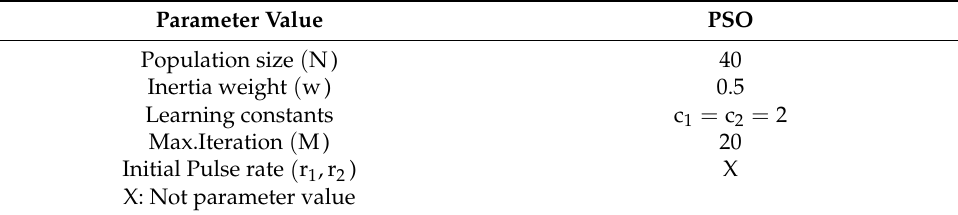
Table 1. PSO Parameter